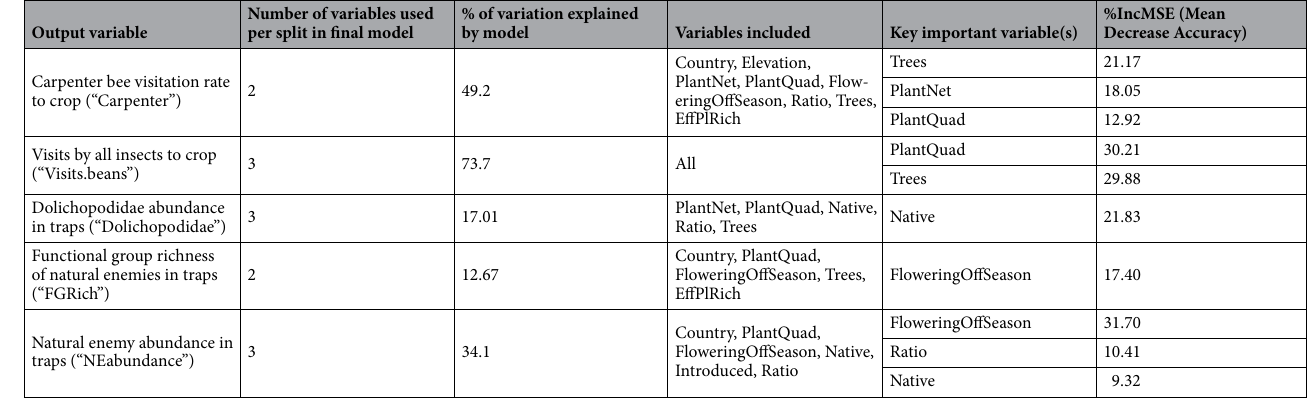
Table 3. Random Forest output summary for main dependent variables. Output variables are defined in the table; for input variables, Country = country location of farm; Elevation = elevation of farm in m asl; PlantNet = number of plant species within network recorded as receiving visits; PlantQuad = species richness at quadrat level (sitewide mean); FloweringOffSeason = species richness of plants in bloom during the podding phase of the crop; Native = native plant species richness; Introduced = introduced plant species richness; Ratio = ratio of native to introduced plants; Trees = mean species richness of trees recorded from quadrat data; EffPlRich = effective plant species number derived from quadrat-level Shannon–Weaver